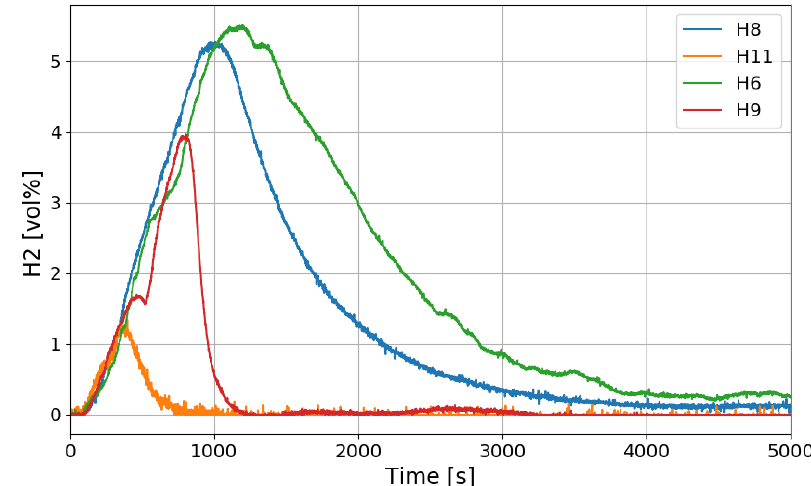
Figure 21. Hydrogen concentrations at inlet and outlet of the PAR for the SP5 test, H6, H9: inlet and outlet of the left lower PAR, H8, H11: inlet and outlet of the right upper PAR.